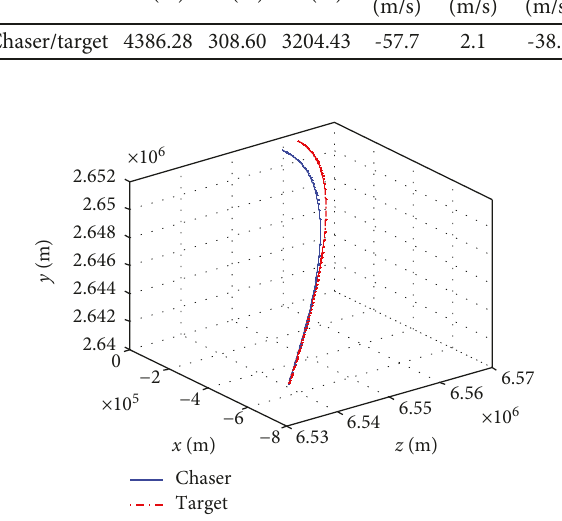
Figure 2: Three-dimensional rendezvous